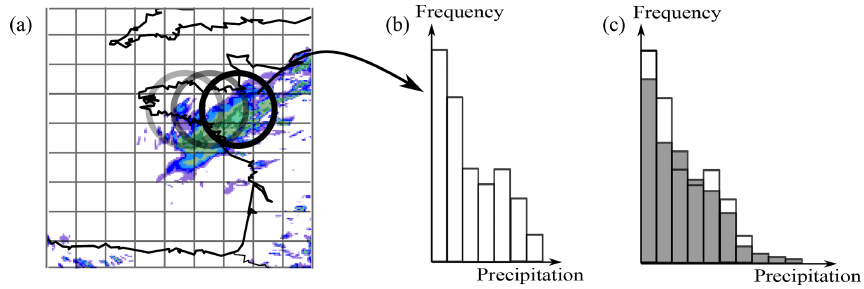
Figure 1. The similarity-based method step by step: (a) the field is scanned using a grid coarser than the original one (resolution of 20km), (b) at each point of this new coarsed grid the local histogram is computed from the high resolution field, and (c) the local histogram is then compared with a reference histogram to classify